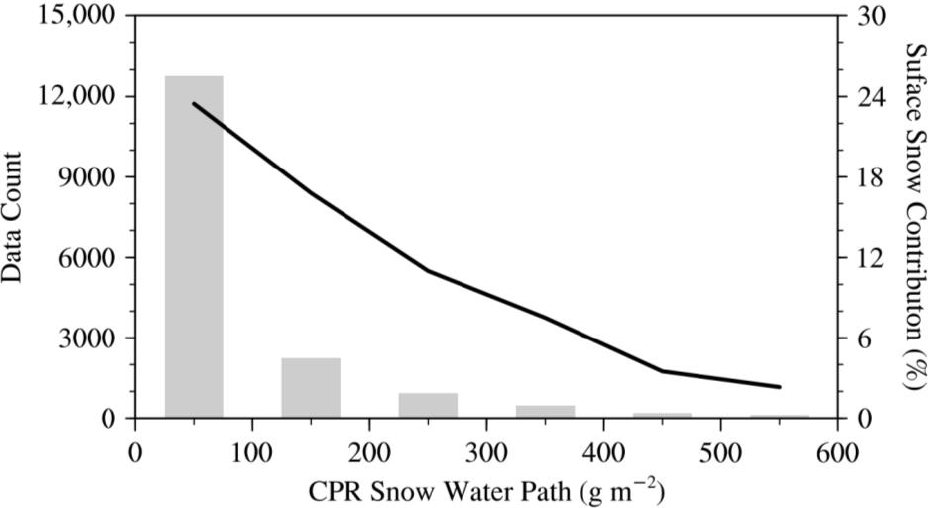
Figure 7. Data count (bar) and surface snow contribution (line) of snow water content profiles grouped by CPR snow water paths under the condition that only CPR detects the falling snow.